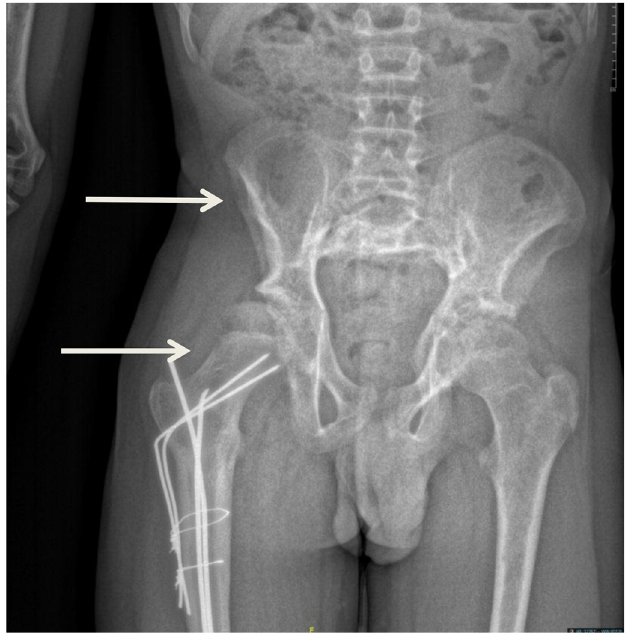
Fig. 1. Pelvis radiograph showing the bone involvement of the Gorham Stout Disease at the right iliac crest and femur (arrows).